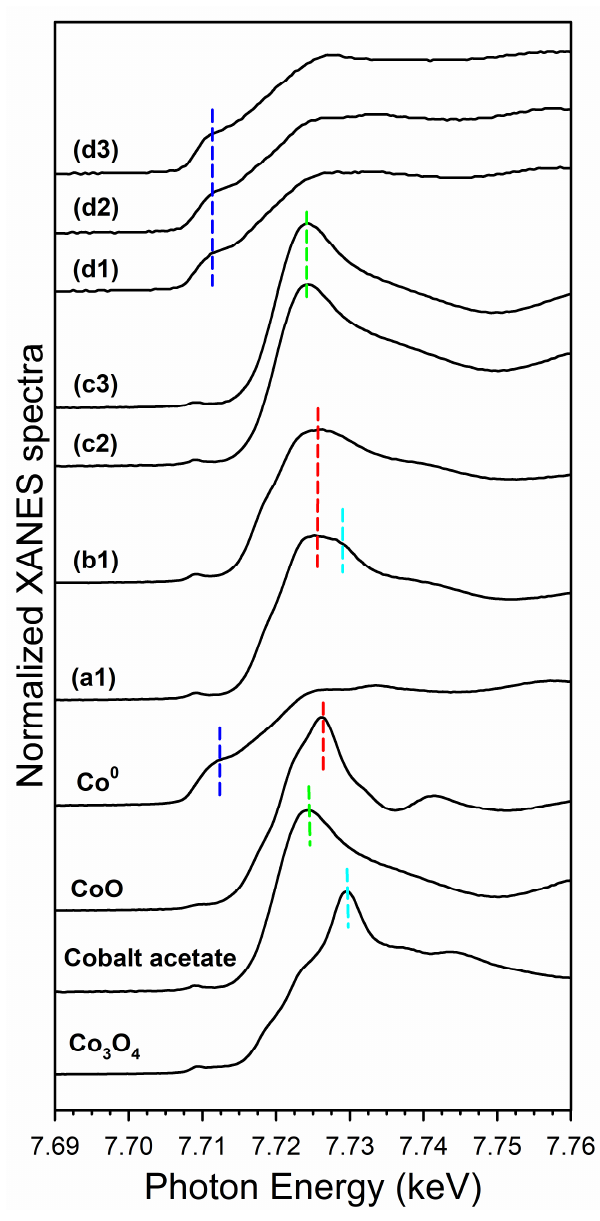
Figure 6. XANES snapshots of references for Co 3 O 4 , CoO, and Co 0 obtained from the TPR-XANES trajectory of the calcined 25% Co/Al 2 O 3 reference catalyst and for cobalt acetate obtained in the initial spectrum of the uncalcined unpromoted catalyst. XANES snapshot spectra for samples prepared from cobalt acetate along the TPR trajectory include (1) the calcined catalyst, (2) the uncalcined catalyst and (3) the uncalcined catalyst with 0.5% Pt promoter at ( a ) the point of maximum spinel (e.g., Co 3 O 4 ), ( b ) the point of maximum CoO following reduction of the spinel, ( c ) the point of maximum cobalt acetate content, and ( d ) the point of maximum Co 0 content following TPR. Dashed lines emphasize the presence of (green) Co 2+ in cobalt acetate, (cyan) Co 3+ (i.e., in addition to Co 2+ ) in the spinel, (red) Co 2+ in CoO, and (blue) Co 0 .